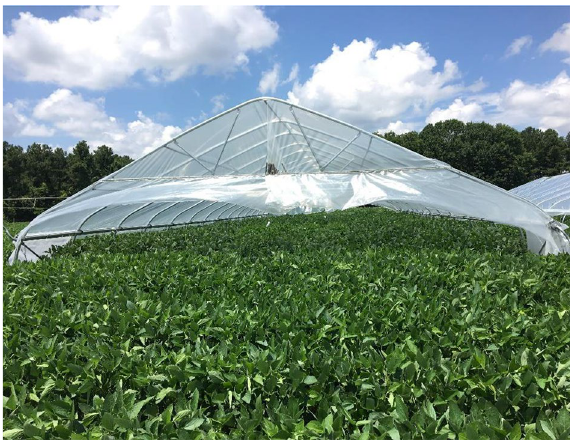
Figure 1. The rainout shelters placed to simulate drought. The picture was taken by Dr. Avat